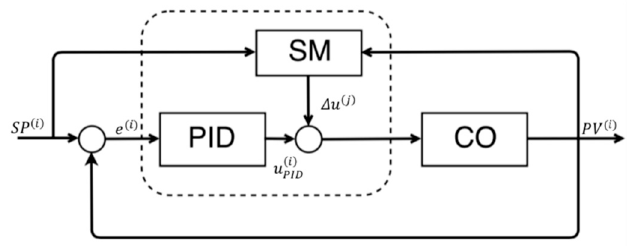
Figure 2. Dynamically updated PID (DUPID) control loop structure.